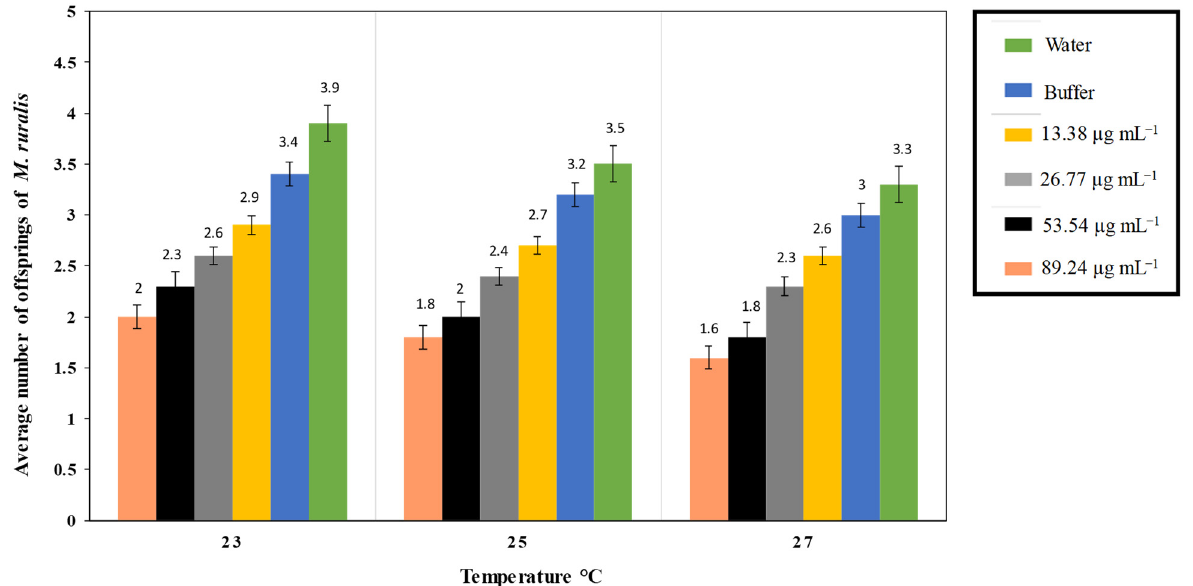
Figure 4. Marasmia ruralis average fecundity ( n = 10), fecundity lessened in O. sativa seedlings treated with PeVL1, (one-way ANOVA with factorial analysis; LSD at α = 0.05). 3.3. PeVL1 Influenced the Development and Structure of O. sativa